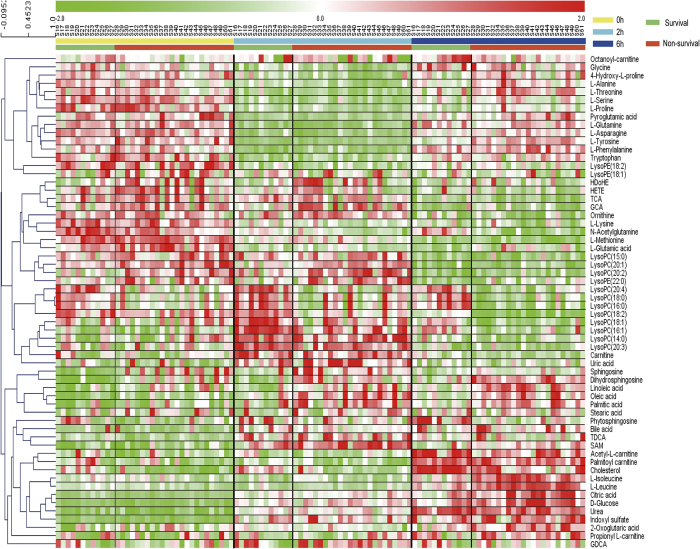
A heatmap representing the metabolic changes in survival and non-survival rats within 0 h to 6 h.Green square indicates a reduction of up to two folds, white square indicates no significant fold change, and red square indicates an increase of up to two folds.